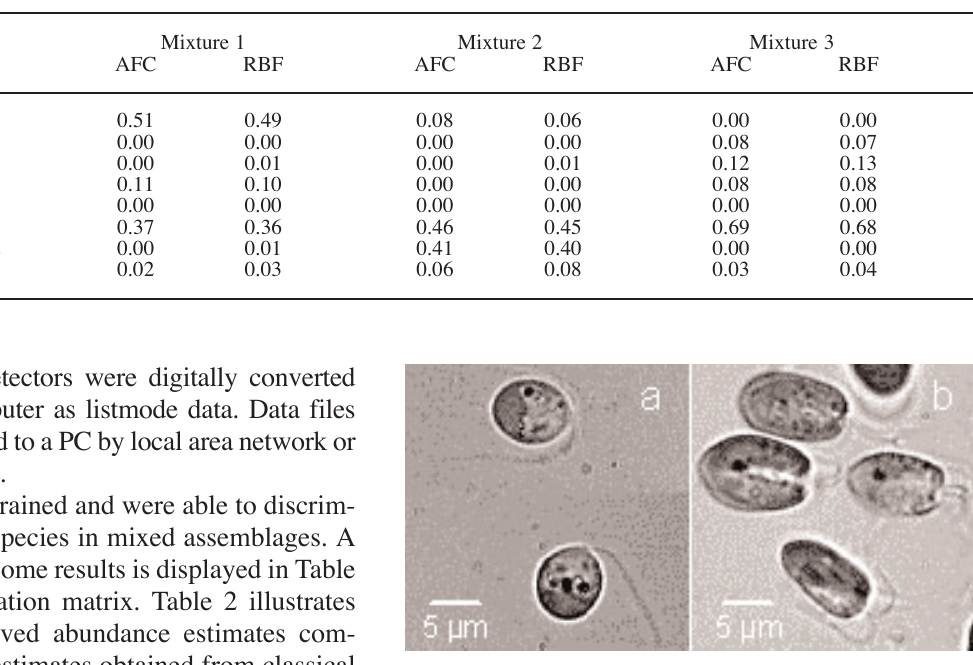
F IG . 2. – CCD camera images of Dunaliella tertiolecta and Tetraselmis suecica taken using the digital image analysis system of the University of Malaga,